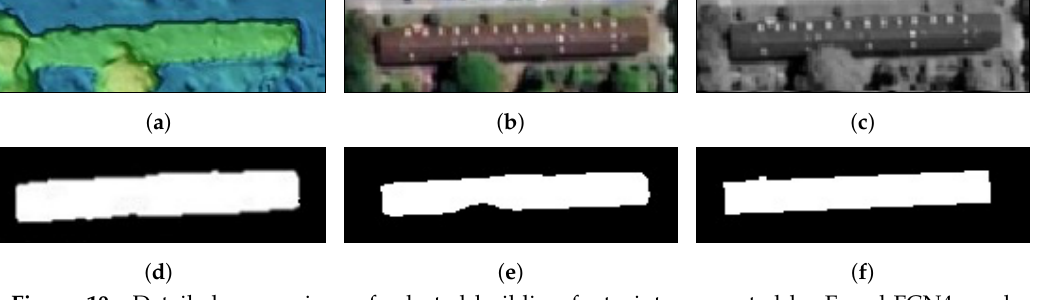
Figure 10. Detailed comparison of selected building footprints generated by Fused-FCN4s and Hybrid-PS-Unet models. ( a ) illustrates the building representation on color-shaded DSM, ( b , c ) show the building on RGB and PAN images, respectively, ( d ) presents the resulted footprint form Hybrid-PS-Unet model, ( e ) displays building footprint from Fused-FCN4s network and ( f ) is a ground truth mask.